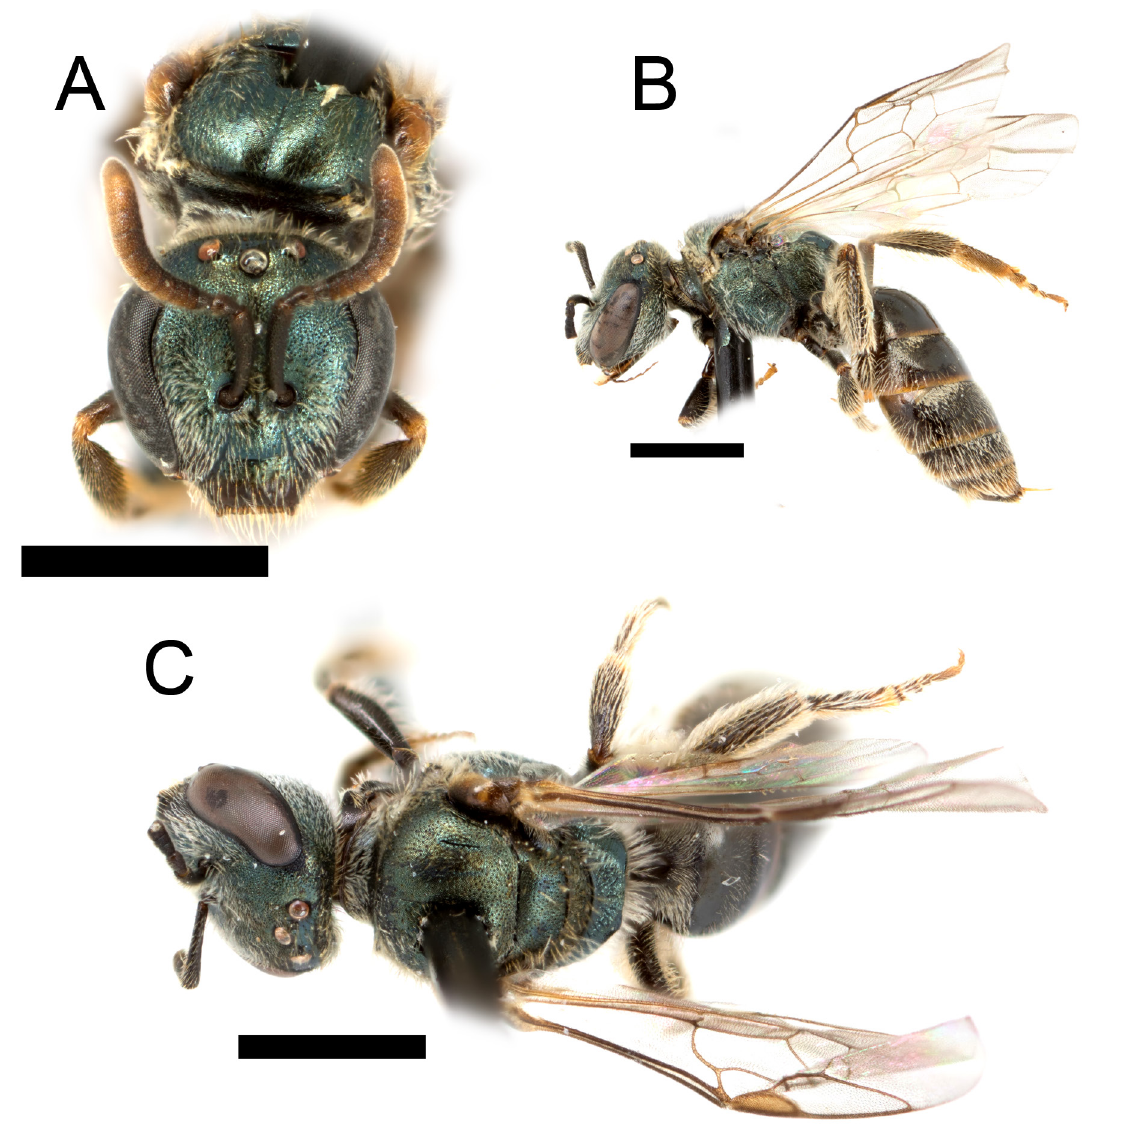
Fig. 9. Lasioglossum enatum sp. nov., ♀. A . Face. B . Lateral habitus. C . Dorsal habitus. Scale bars = 1